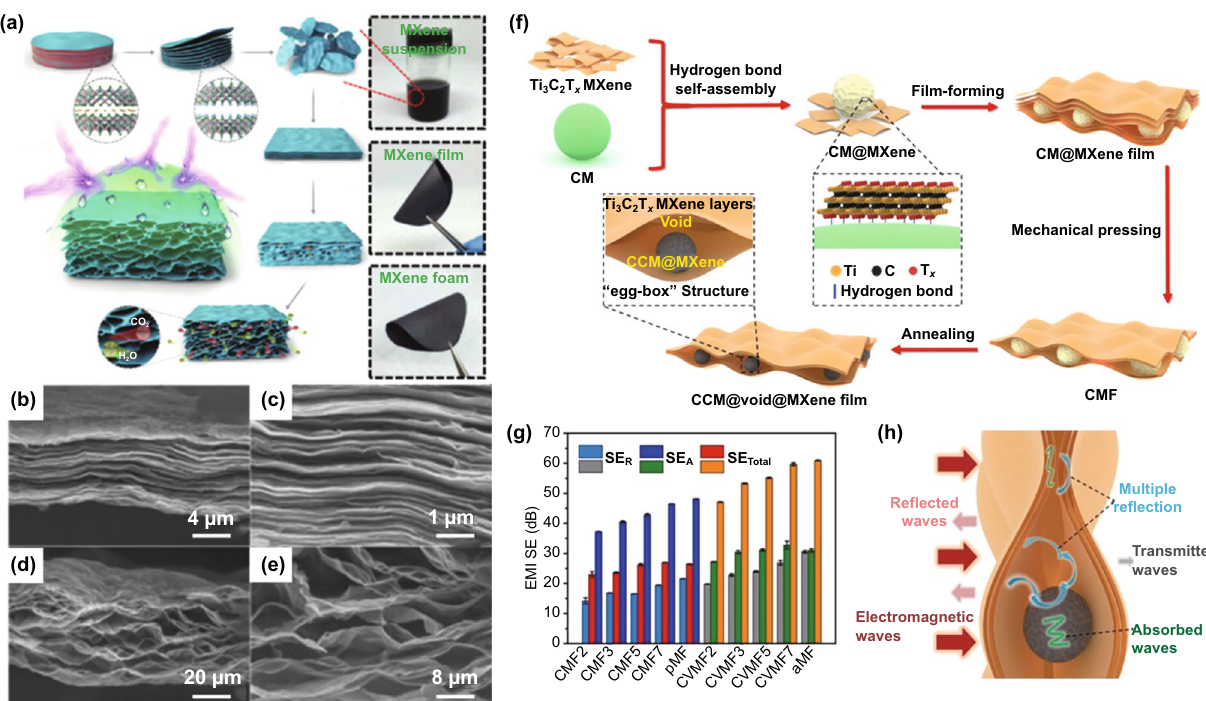
Fig. 5 a Schematic illustration of the fabrication of the hydrophobic and flexible MXene foam. Cross-sectional SEM images of b, c the MXene film and d, e the MXene foam [105]. Copyright © 2017 WILEY ‐ VCH Verlag GmbH & Co. KGaA, Weinheim; f schematic illustration for the fabrication of CVMF; g comparison of average SE A , SE R and SE T for CMF, pMF, CVMF and aMF in X-band; h schematic description of